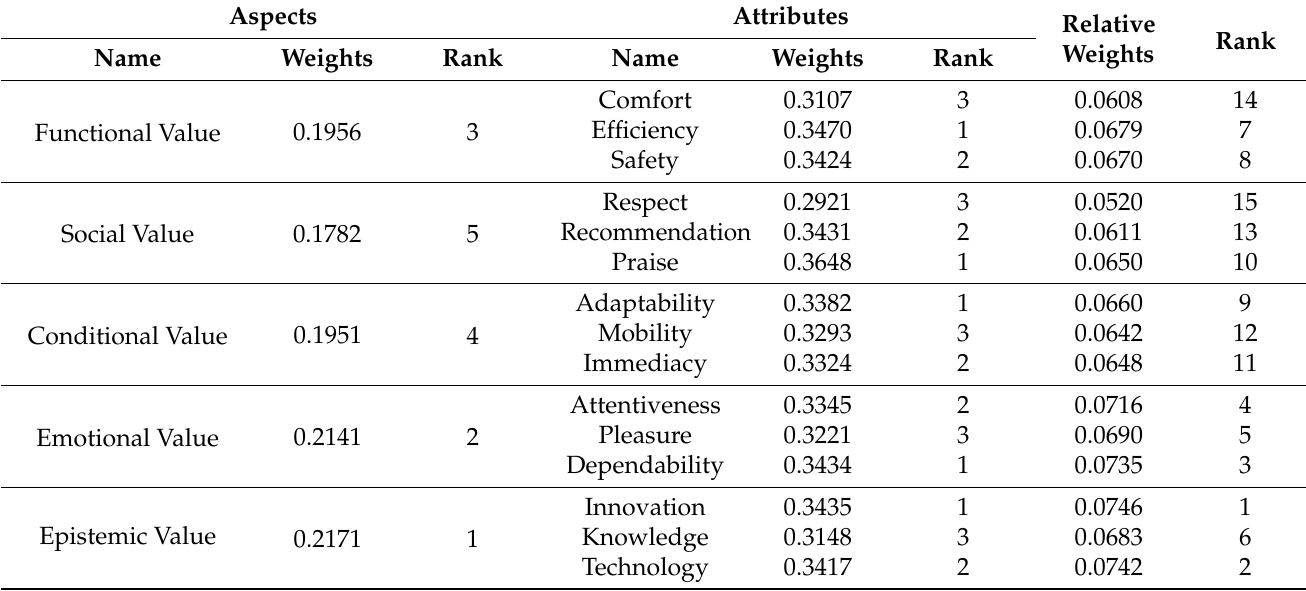
Table 10. Travel agencies service quality